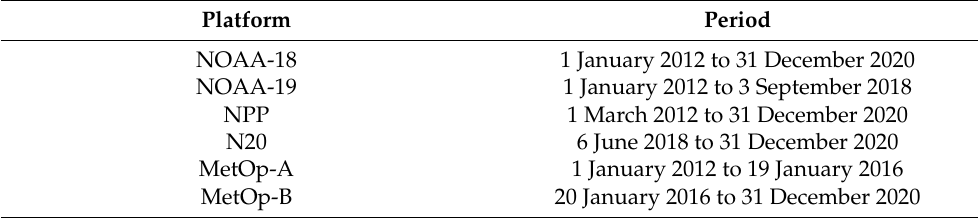
Table 3. Dates when platforms were included in the reprocessing of Multi-sensor L3S